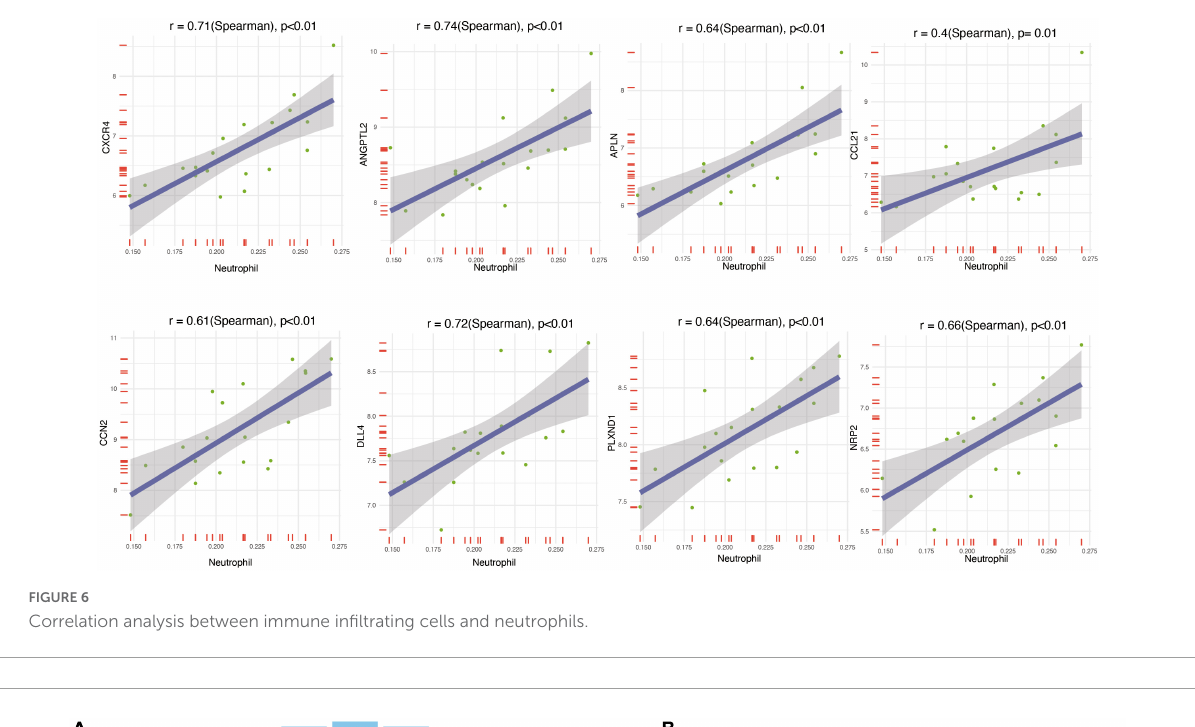
FIGURE6 Correlation analysis between immune infiltrating cells and neutrophils.